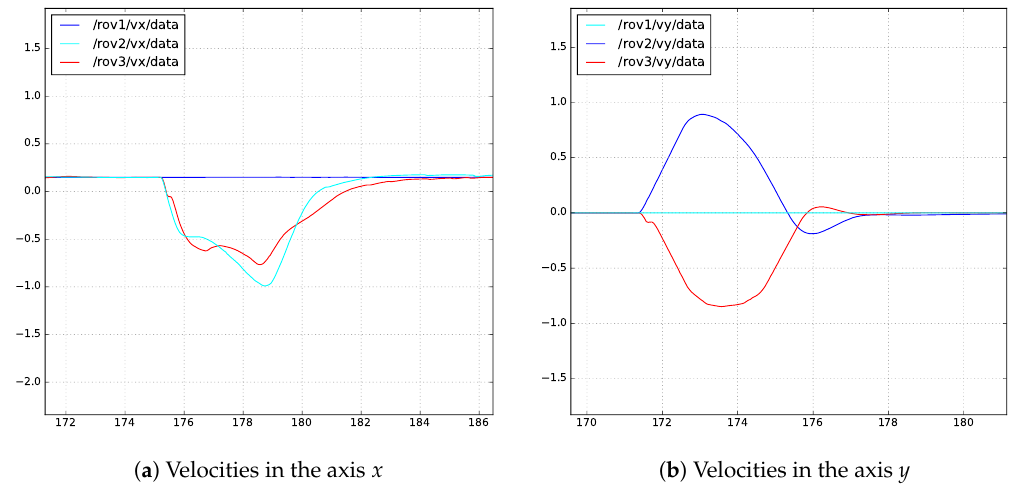
Figure A1. Velocities of three BlueROV-1 while crossing a narrow